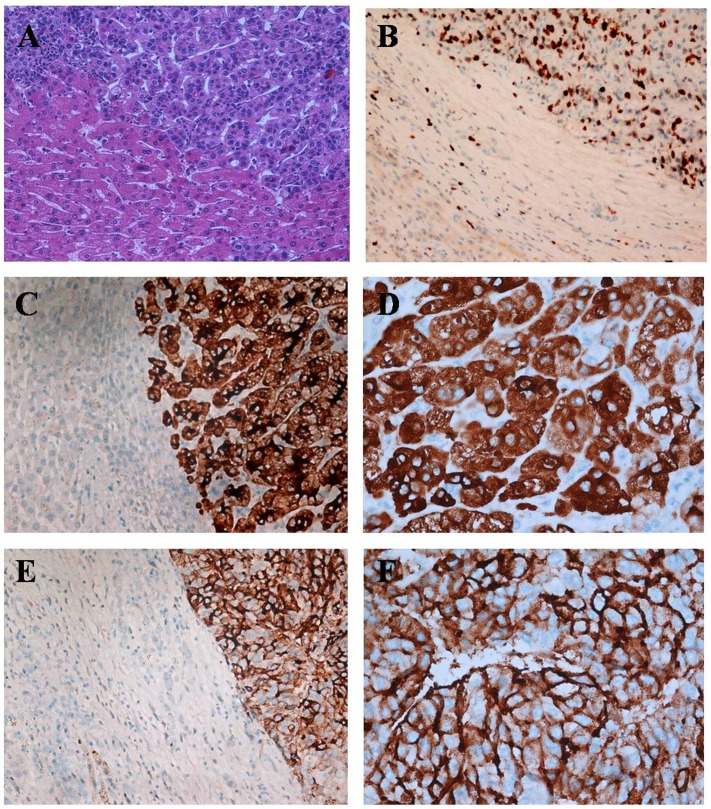
Positive expression of OPN and αvβ3 protein in hepatocellular carcinoma (HCC).(A) HE staining. The nuclei of tumor cells are large, and have atypia, which are different from those of adjacent non-tumorous hepatocytes (HE 20×10). (B) Ki-67 immunohistochemical staining. Ki-67 expression is observed in the nucleus and is visualized as brown-yellow staining. Ki-67 index is higher in tumor but lower in adjacent non-tumorous hepatic tissues (SP 20×10). (C&D) OPN expression is predominantly observed in the cytoplasm and is visualized as brown-yellow staining. The expression of OPN is negative in adjacent non-tumorous tissue (C: SP 20×10, D: SP 40×10). (E&F) αvβ3 immunohistochemical staining. Expression of αvβ3 is observed predominantly in the membrane or cytoplasm and is visualized as brown-yellow staining. The expression of αvβ3 is negative in the adjacent non-tumorous tissue (E: SP 20×10, F: SP 40×10).